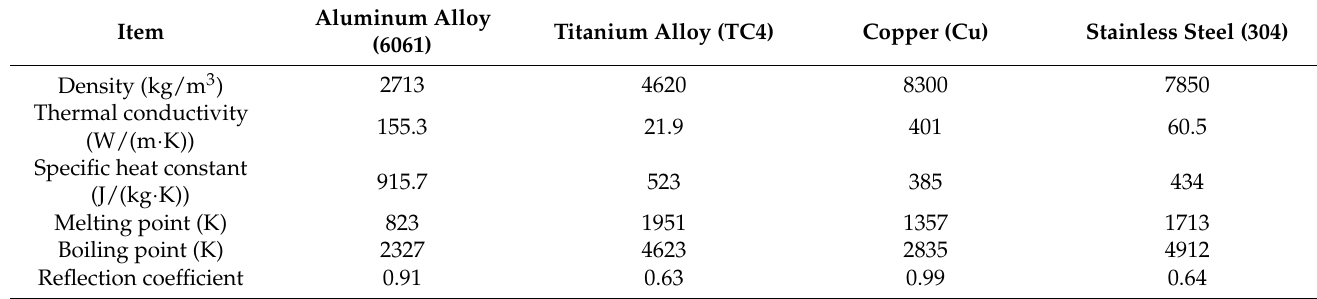
Table 2. Thermal performance parameters of